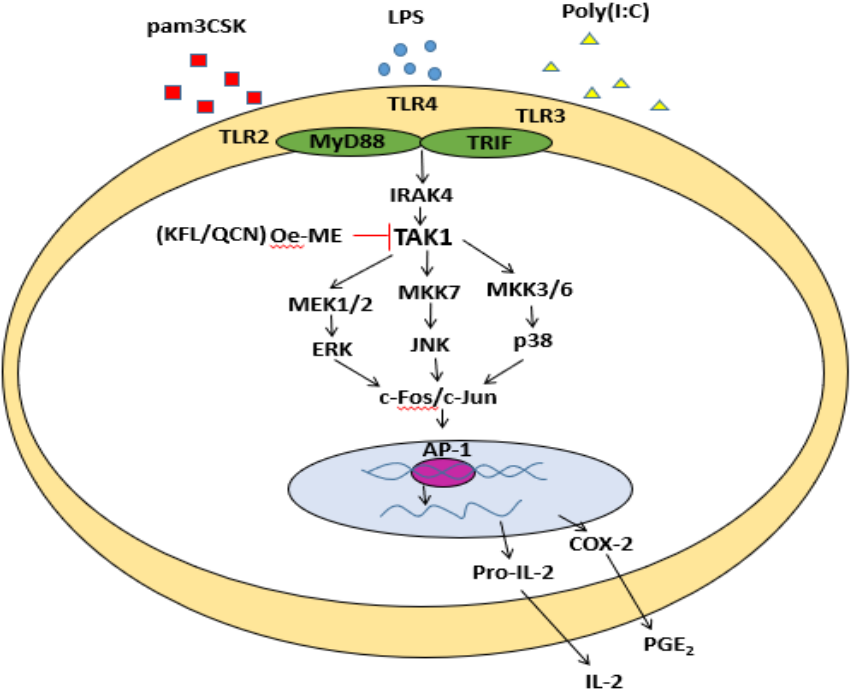
Figure 5. The schematic pathway of Oe-ME-regulated anti-inflammatory responses. Oe-ME inhibits TAK1 kinase activity in AP-1 pathway, leading to anti-inflammatory effects.